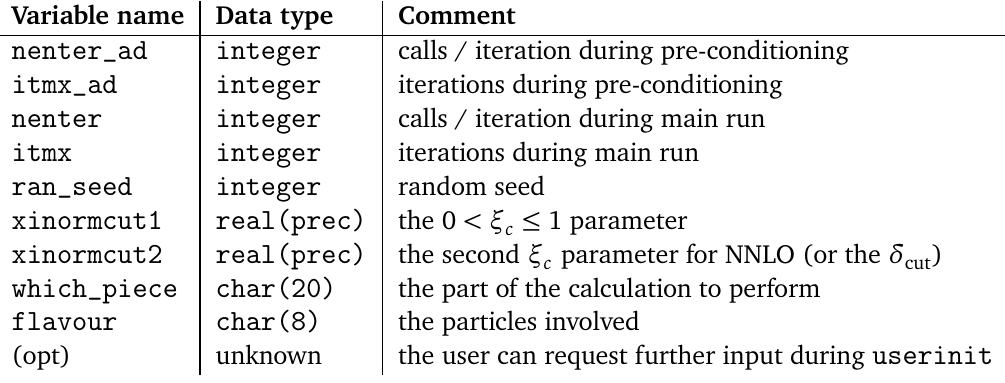
Table 1: The options read from stdin by McMule. The calls are multiplied by